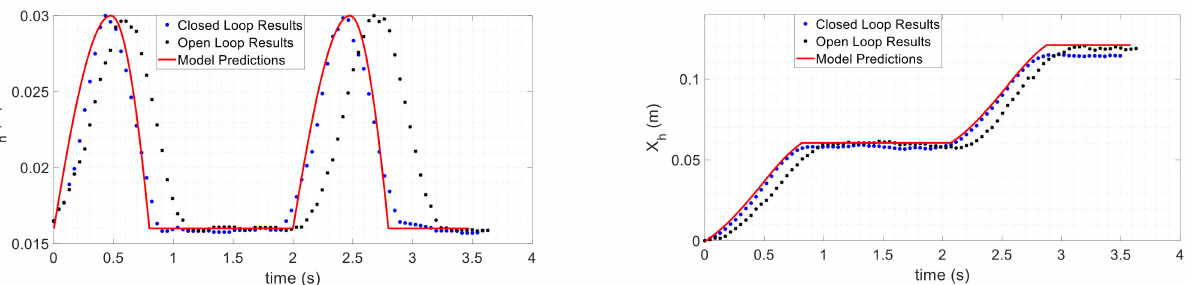
Figure 15. Graphs showing the evolution of y h ( left ), and of x h ( right ) in time throughout two revolutions at 30 rpm in the open loop and in the close loop control, r = 0.015